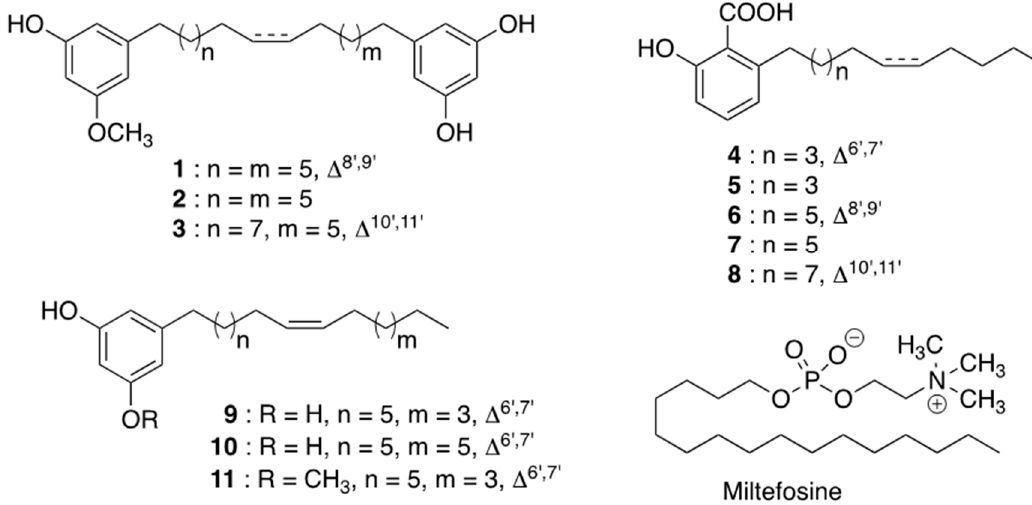
Figure 1. Structures of compounds 1 – 11.